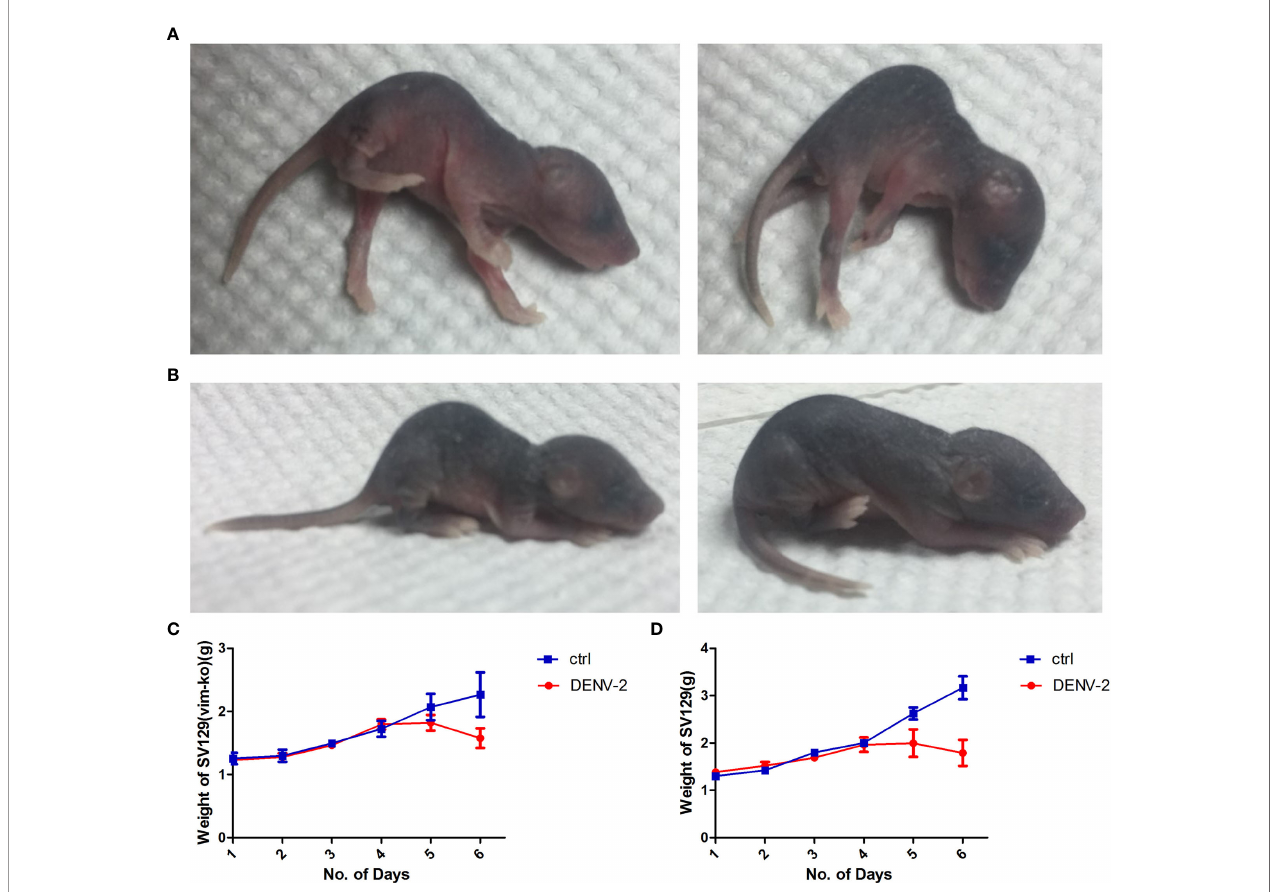
FIGURE 4 | Disease signs and weight changes in SV129 and SV129 (Vim-KO) mice after infection with dengue virus (DENV)-2. (A, B) Signs in SV129 and SV129 (Vim-KO) mice with DENV-2 infection. (C, D) Weight changes in SV129 and SV129 (Vim-KO) mice with DENV-2